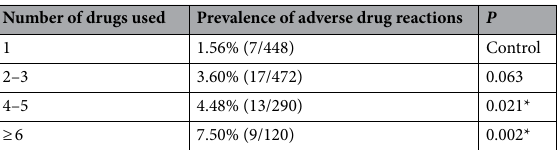
Number of drugs used Prevalence of adverse drug reactions